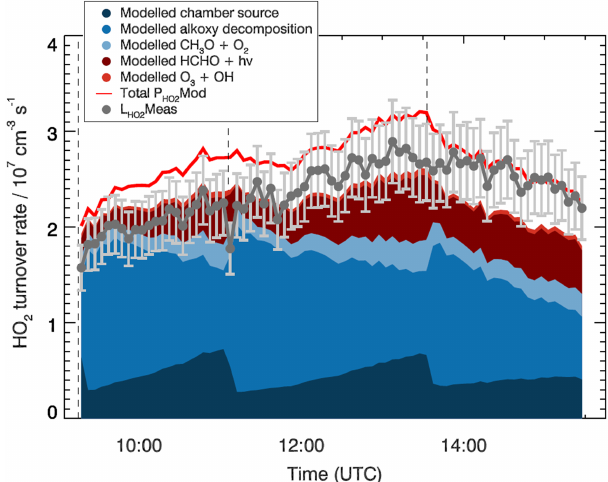
Figure 3. OH budget for the MBO experiment. The experimen- tally determined total OH loss rate, L OH , and individual produc- tion terms are shown. For comparison, the red line indicates the to- tal modelled OH production, P OH Mod, which equals the modelled loss rate. Vertical dashed lines indicate the times when MBO was injected. Error bars (1 σ ) for L OH include the accuracy of measure- ments.